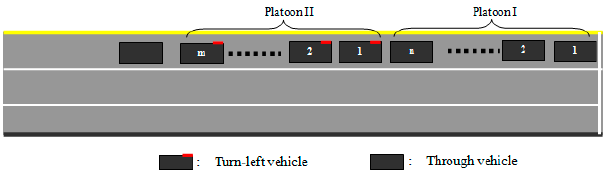
Figure 6. Platoons on the shared lane.